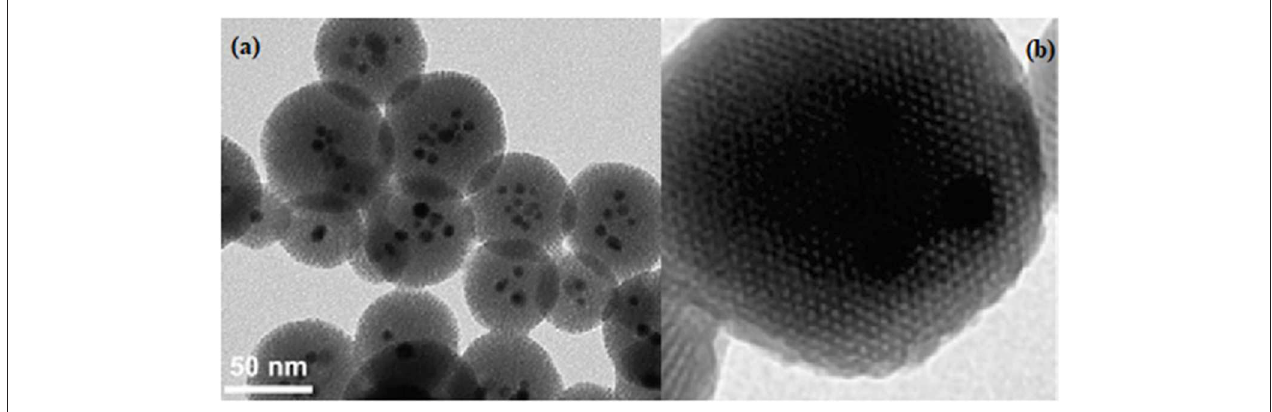
FIGURE 4 | Typical TEM image for (a) mixed iron-oxide and silver mesoporous silica and (b) Zn embedded in mesoporous